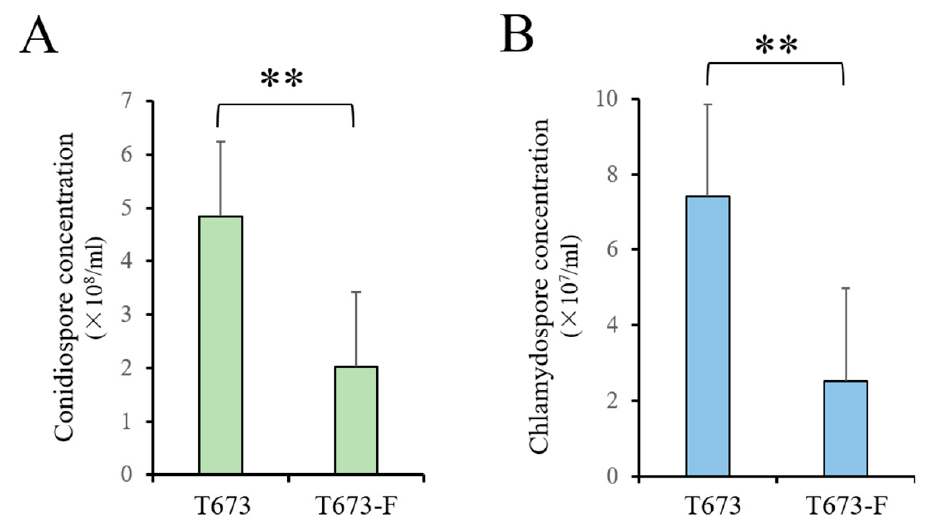
Figure 4. Conidiation and chlamydospore formation by strain T673 and partitivirus ThPV2-free strain T673-F. ( A ): Conidiospore formation was quantified on PDA at 5 dpi post inoculation. ( B ): Chlamydospore production was quantified on chlamydospore induction medium at 5 dpi. Double asterisks indicate highly significant differences ( p < 0.01).